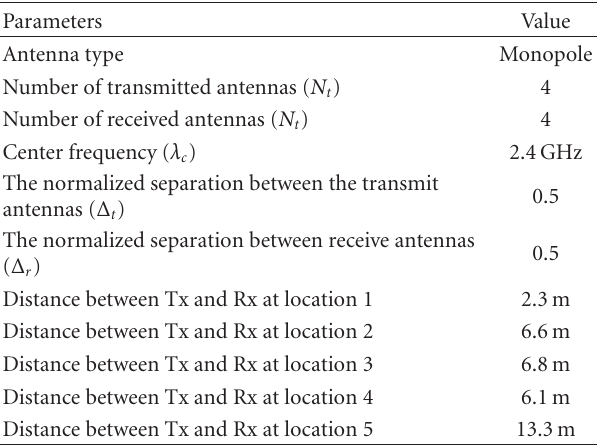
Table 3: The parameters used for